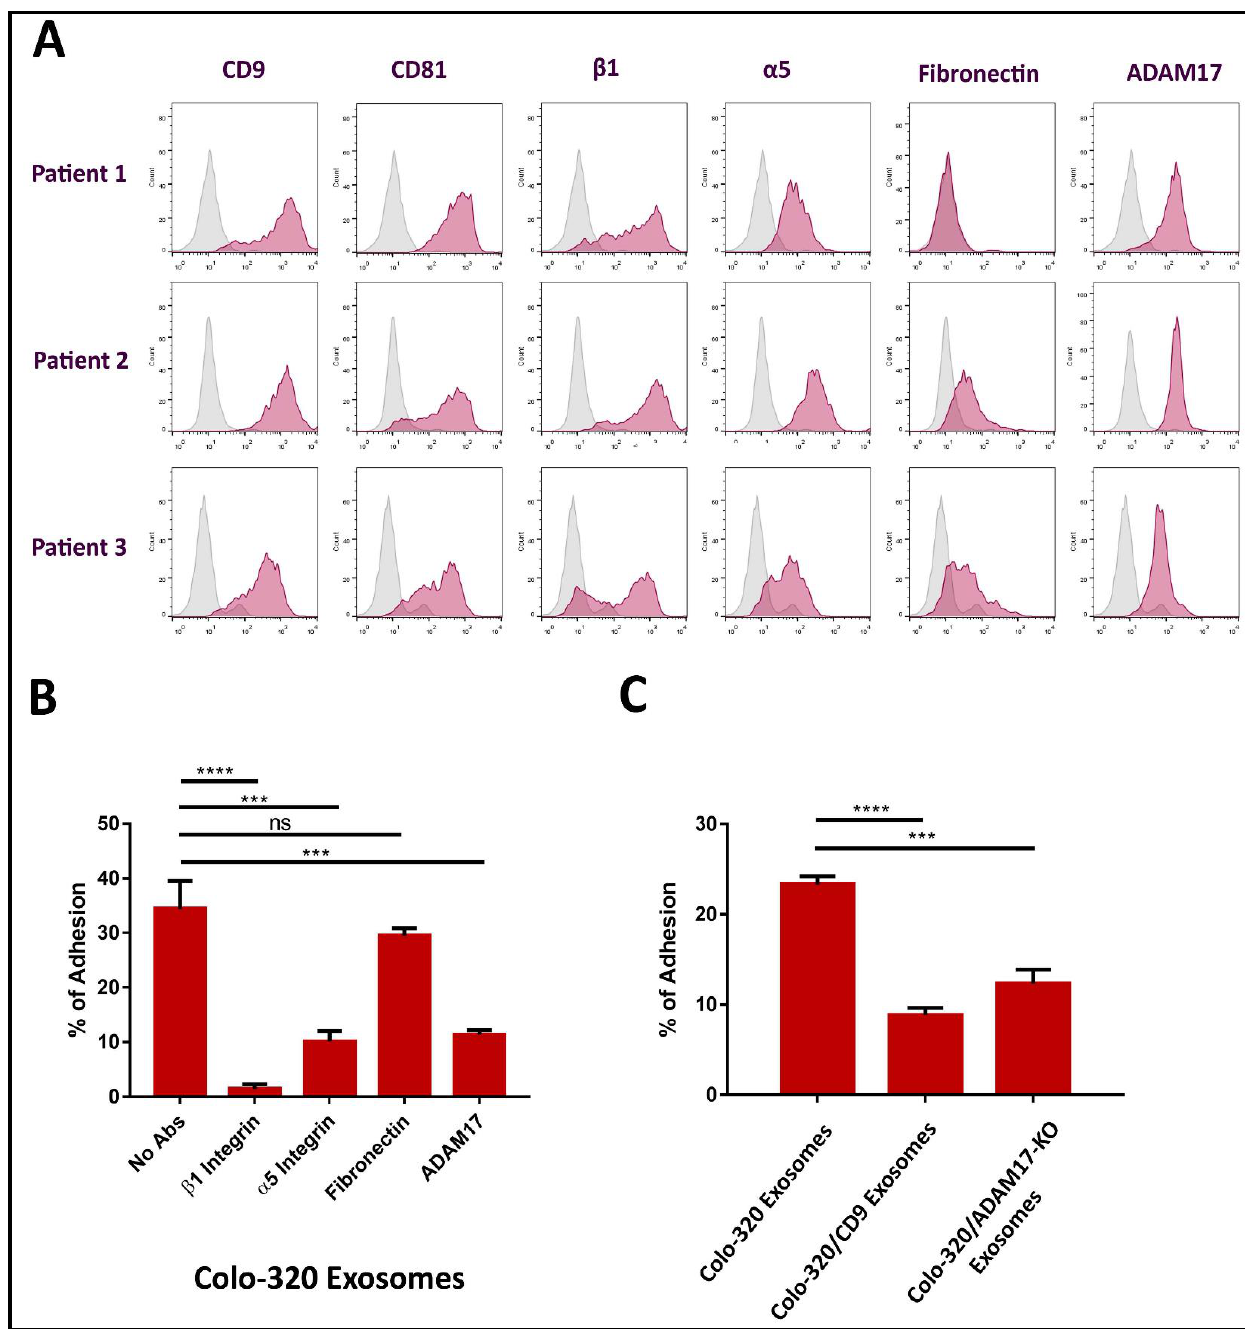
Figure 6. The presence of exosomal CD9 and the absence of exosomal ADAM17 reduced the adhesion of primary mesothelial cells to exosomes produced by CRC Colo-320 cells. ( A ) Flow cytometry detection of CD9, CD81, integrin β 1, integrin α5, ADAM17 , and fibronectin on the surface of primary mesothelial cells from three different donors. ( B ) Adhesion of primary mesothelial cells (from the three patients in ( A )) to immobilized exosomes produced by Colo-320 cells in presence of blocking mAbs specific for β 1 integrin, α 5 integrin, fibronectin and the Dis domain of ADAM17. ( C ) Adhesion of primary mesothelial cells (from the three patients in ( A )) to immobilized exosomes produced by Colo-320, Colo-320/CD9 and Colo-320/ADAM17-KO cells. The percentage of cells that remained adhered is indicated as mean ± SEM of three experiments (one for each patient), performed in duplicates. Statistical analysis performed was one-way ANOVA. *** p < 0.001, **** p < 0.0001, ns: not statistically significant.